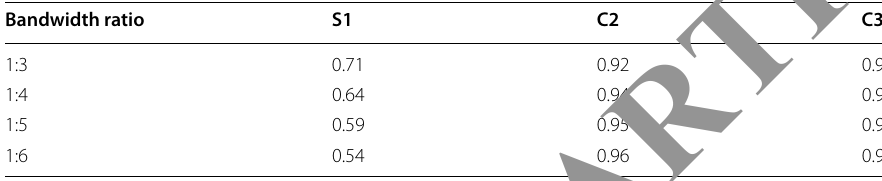
Table 7 Design parameters of three TMI power allocation ratios under different bandwidth ratios Bandwidth ratio S1 C2 C3